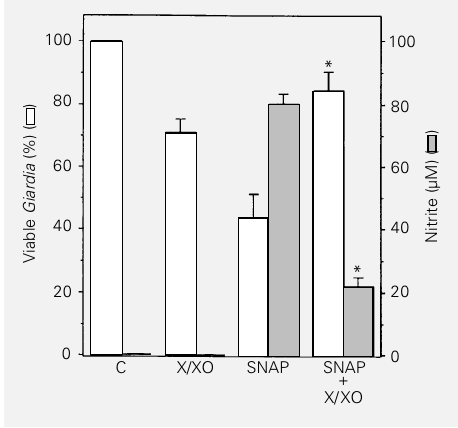
Figure 5 - Effect of increasing concentrations of authentic per- oxynitrite on Giardia trophozoite killing. Peroxynitrite anion was obtained as described in the Methods section and incubated with trophozoites for 2 h at 37 o C. Addition of peroxynitrite did not change medium pH. Re- sults are reported as means – SD of triplicates. *P<0.05 when compared to the group without peroxynitrite (analysis of vari- ance followed by the Bonferroni t -test). The same results were obtained in two